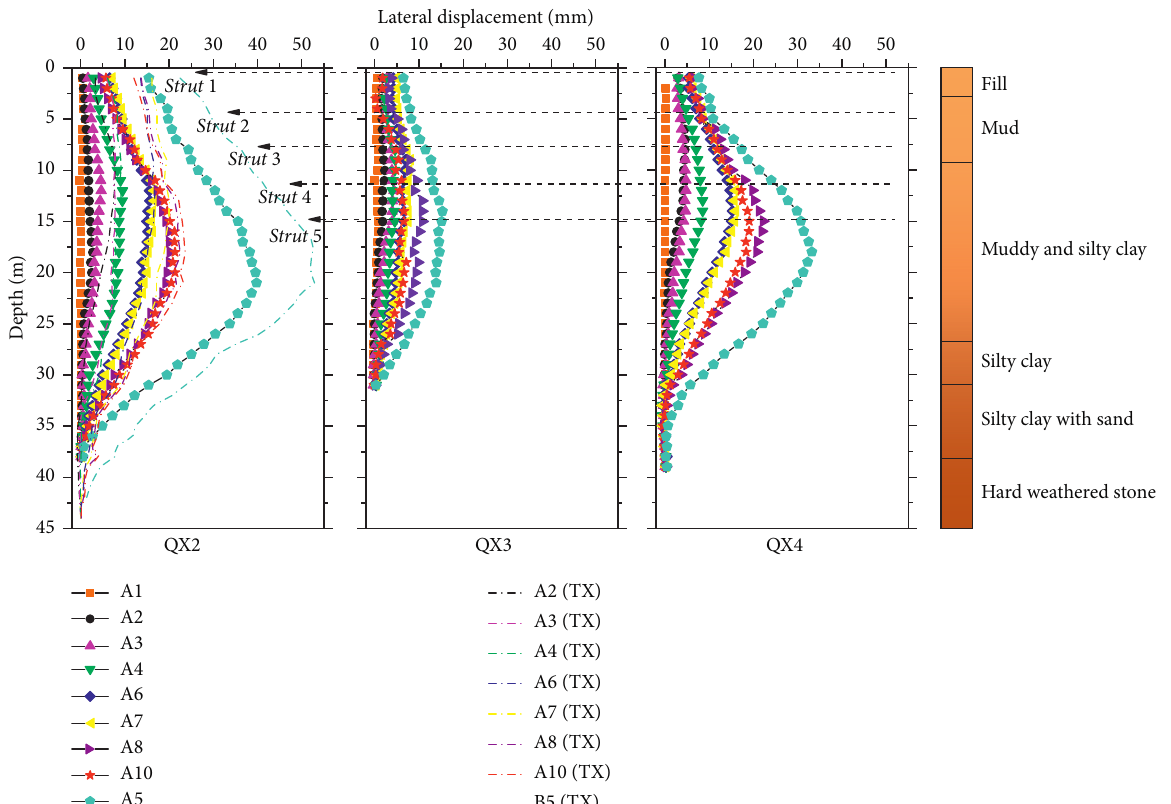
Figure 9: Lateral displacement of the diaphragm wall in